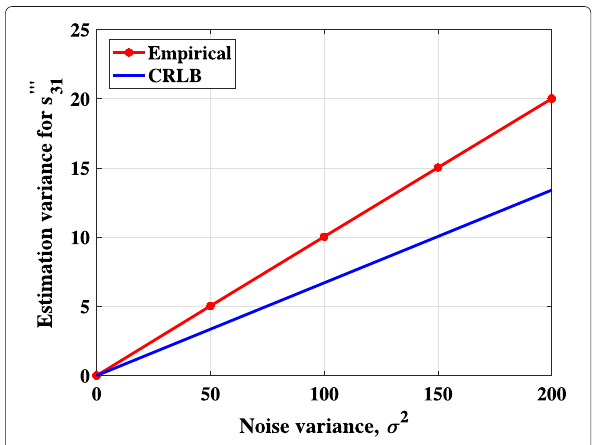
Fig. 4 Estimation variance for s (cid:4)(cid:4)(cid:4) 31 as function of the noise power σ 2 , compared to the CRLB